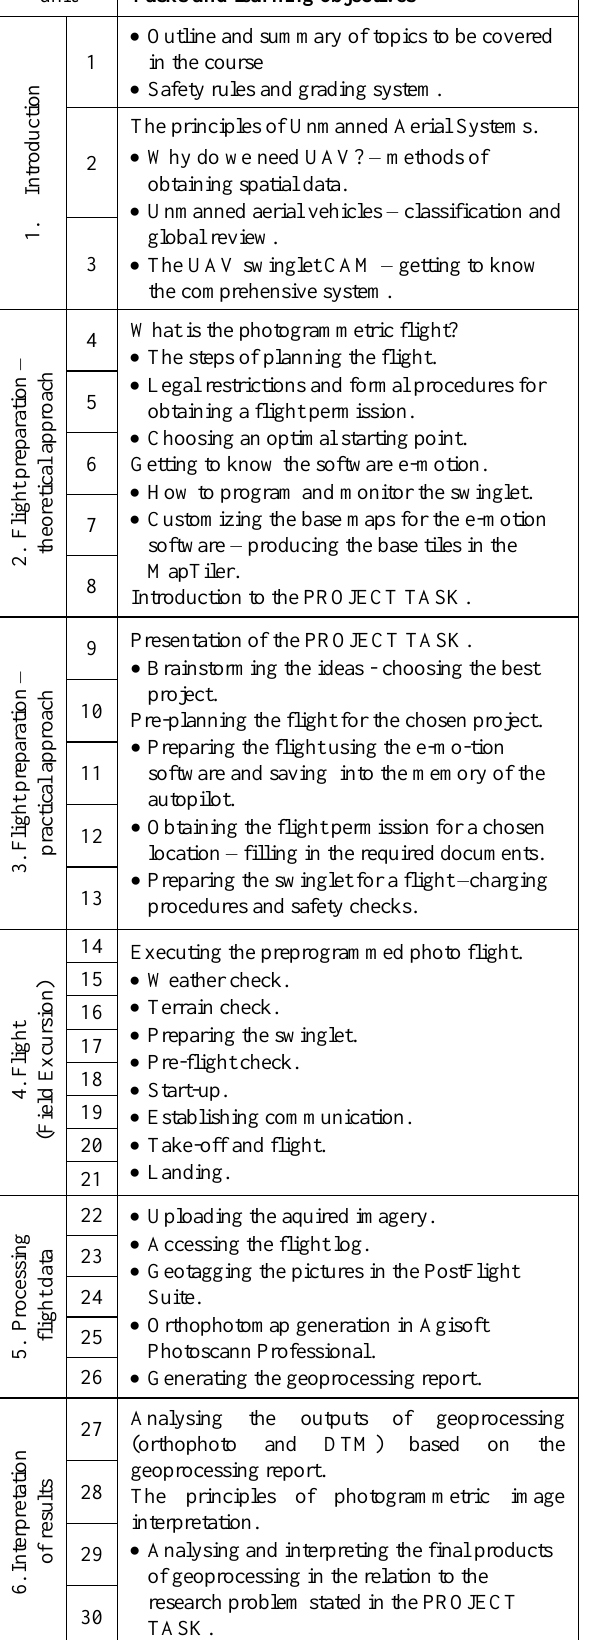
Table 2. Tasks and learning objectives of the course unit Tasks and learning